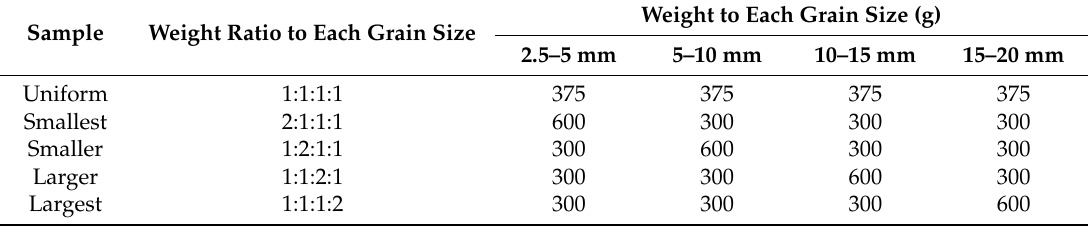
Figure 4. A sieving machine with high frequency vibration: ( a ) sieve machine; and ( b ) a 10 mm sieve. Table 1. Coal grain size distribution of each sample.